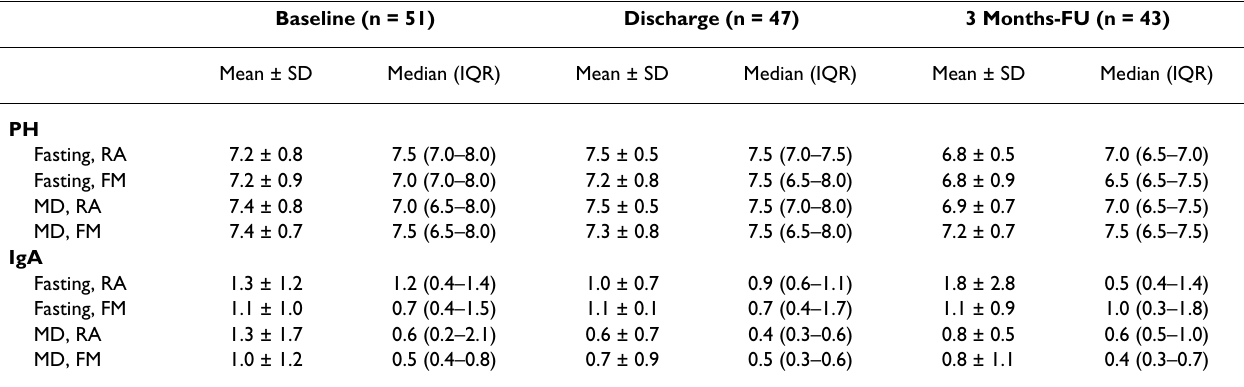
Table 4: Stool pH and secretory immunoglobulin A (sIgA) stool concentrations according to group assignment in the study course: No statistically significant change between different time points within and between